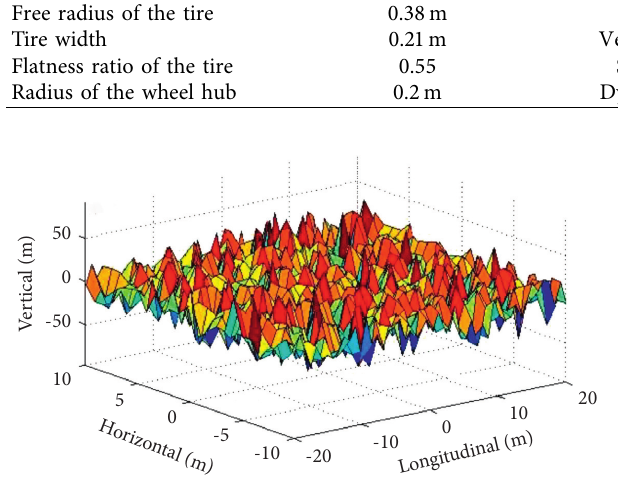
Figure 3: Grade e